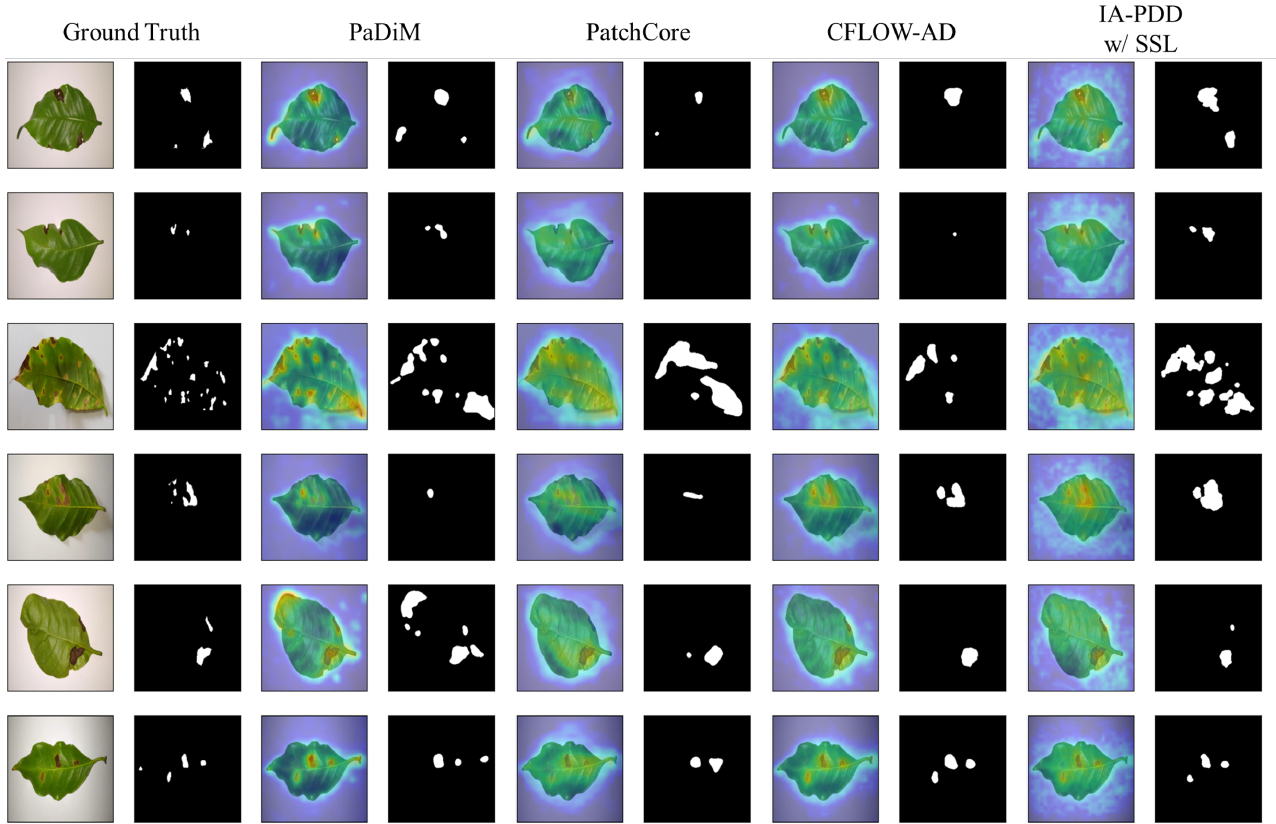
Figure 3. Qualitative results on BRACOL dataset. The first two columns show input images and corresponding ground truth mask, respectively. The remaining group of columns represents the heat maps and corresponding predicted masks of the other state-of-the-art methods. In addition, each row shows qualitative results for randomly selected cases from the BRACOL